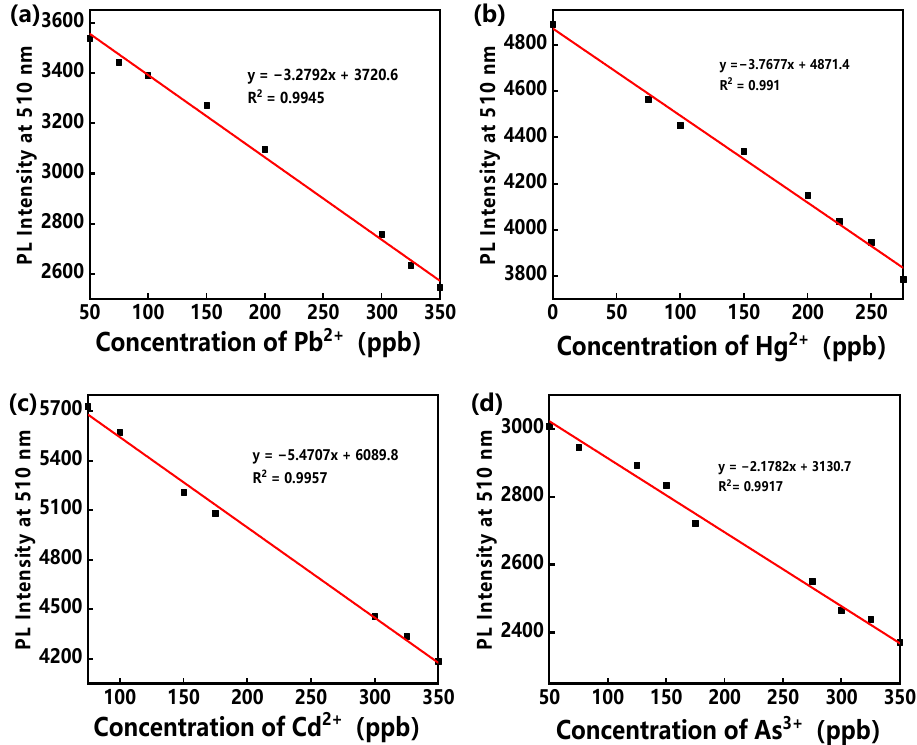
Figure 5. The relationships between PL intensities of MES-treated hybrid assemblies and various concentrations of ( a ) Pb 2+ , ( b ) Hg 2+ , ( c ) Cd 2+ and ( d ) As 3+ . In order to verify the feasibility of the detection method in actual samples, shrub branches and leaves were selected. Their heavy metal ion content was determined using inductively coupled plasma mass spectrometry (ICP-MS). Figure 6 shows the estimated results for the content of heavy metal ions in the sample: 72.21 ppb, 2.00 ppb and 10.27 ppb for Pb 2+ , Cd 2+ and As 3+ , respectively. The results were all within the reference concentration range. The result that Hg 2+ was not detected in the sample was also consistent with the results provided by ICP-MS.